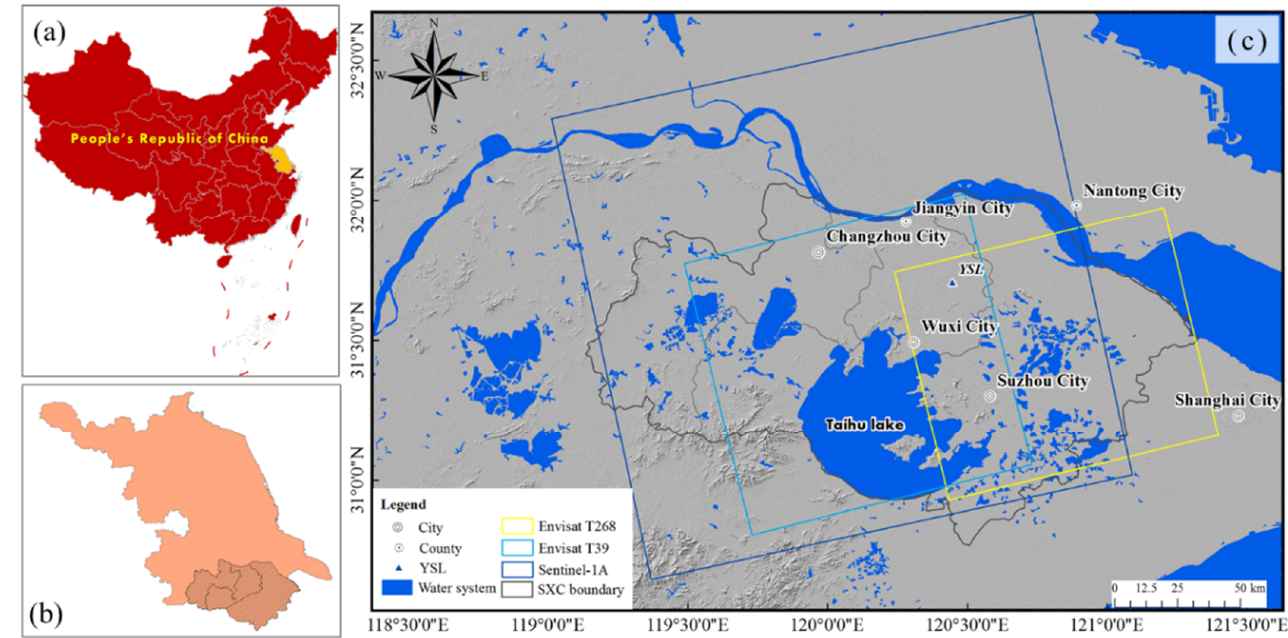
Figure 1. Geographical location of Su-Xi-Chang area. ( a ) Geographical position of Jiangsu Province in China. ( b ) Geographical location of Su-Xi-Chang area in Jiangsu Province. ( c ) SAR image coverage. YSL stands for Yangshuli where the GF disaster occurred.